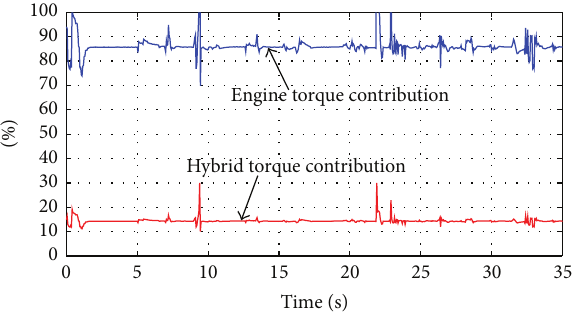
Figure 17: Torque contribution.